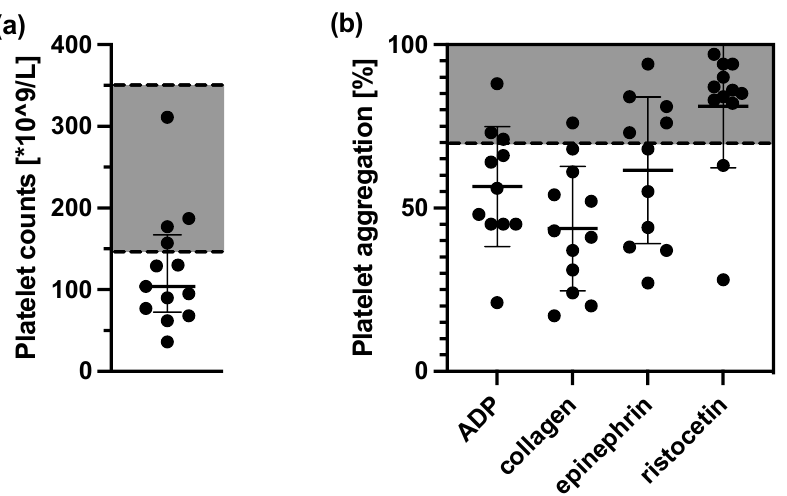
Figure 1. Platelet counts ( a ) and platelet aggregation analysis of COVID-19 patients ( n = 13) after stimulation with ADP, collagen, epinephrin, or ristocetin. ( b ) Gray area marks normal range. Bars depict mean ± SD.